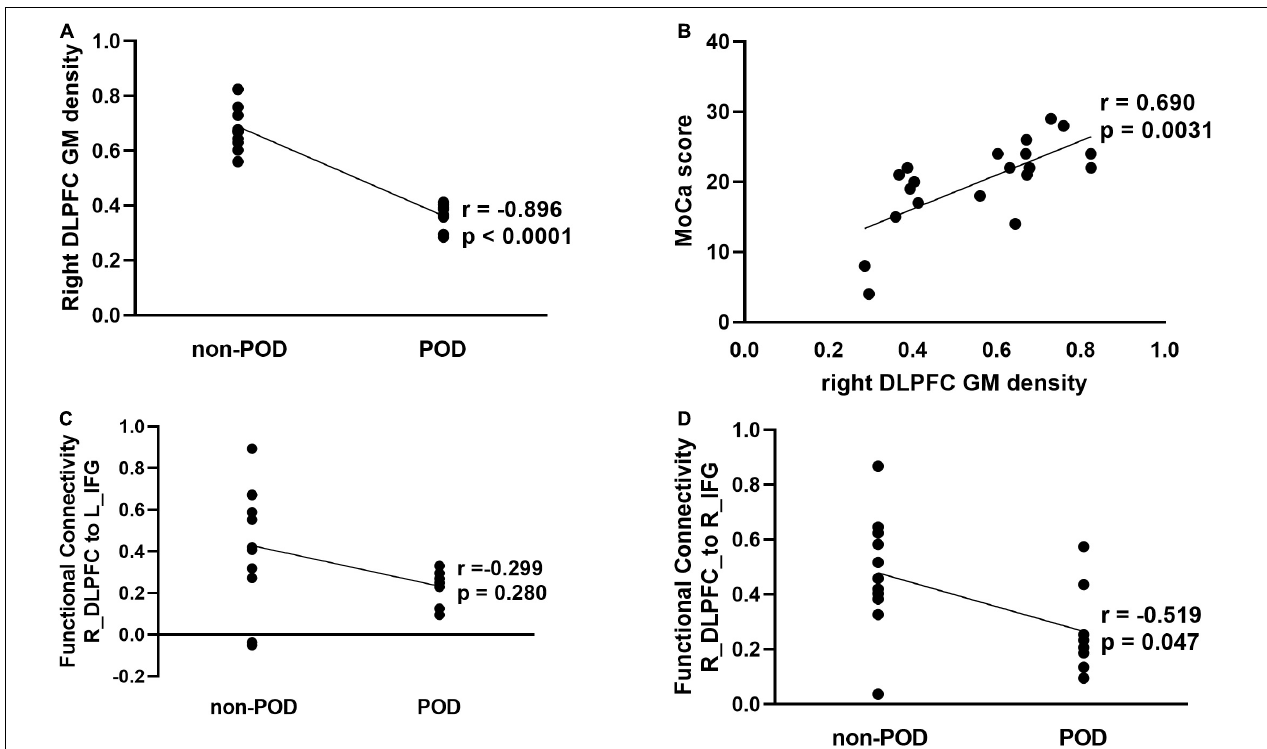
FIGURE 3 | Correlation analysis between structural and functional alterations in the contralesional DLPFC and POD in patients with left frontal lobe glioma. (A) Partial correlation analysis between mean GM density of right DLPFC and POD ( r = –0.896, P < 0.001). (B) Partial correlation analysis between mean GM density of right DLPFC and preoperative montreal cognitive assessment (MOCA) scores ( r = 0.690, P = 0.003). (C) Partial correlation analysis between function connectivity from DLPFC_R to IFG_L_6_2 and POD ( r = –0.299, P = 0.280). (D) Partial correlation analysis between function connectivity from DLPFC_R to IFG_R_6_2 and POD ( r = –0.519, P = 0.047). DLPFC, dorsolateral prefrontal cortex; GM, gray matter; HC, health control; IFG, inferior frontal sulcus; L, left; POD, postoperative delirium; R,